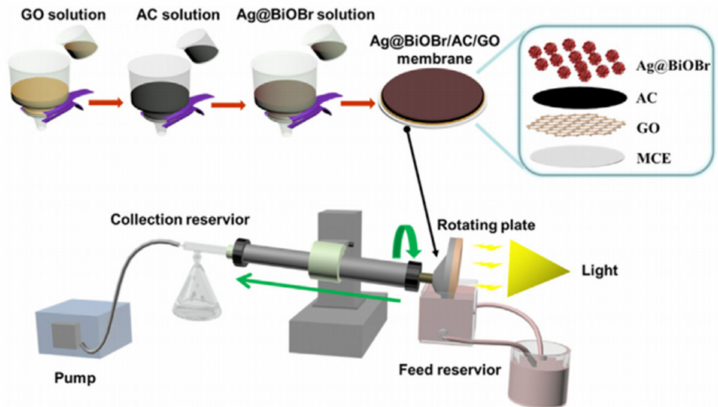
Figure 9. Illustration of rotating reactor and preparation of Ag@BiOBr/AC/GO membrane by Zhan et al. Reprinted with permission from ref. [123]. Copyright © 2021 Elsevier